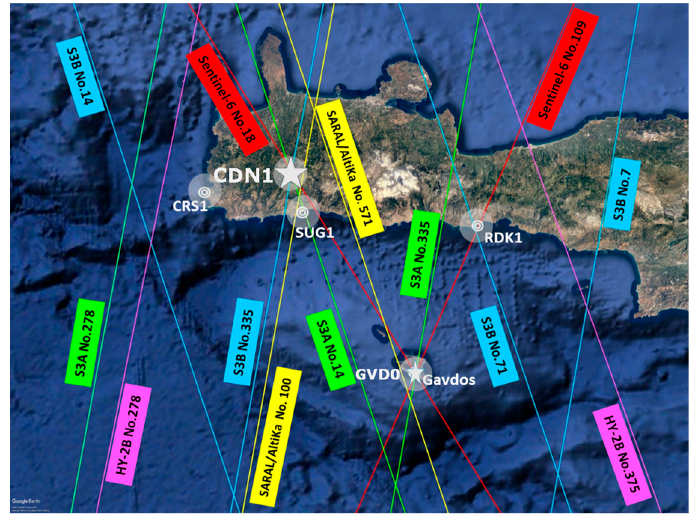
Figure 3. The Permanent Altimeter Calibration Facility of the European Space Agency in Crete and Gavdos. The various Cal/Val sites (CDN1, GVD0, RDK1, CRS1, and the upcoming SUG1) used for the calibration of Jason, Saral/Altika, HY-2, Sentinel-3, and CryoSat-2 are shown.